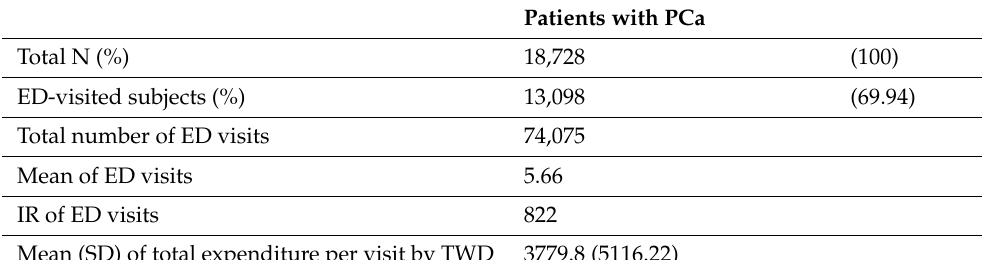
Table 1. Utilization of emergency department among patient with prostate cancer.